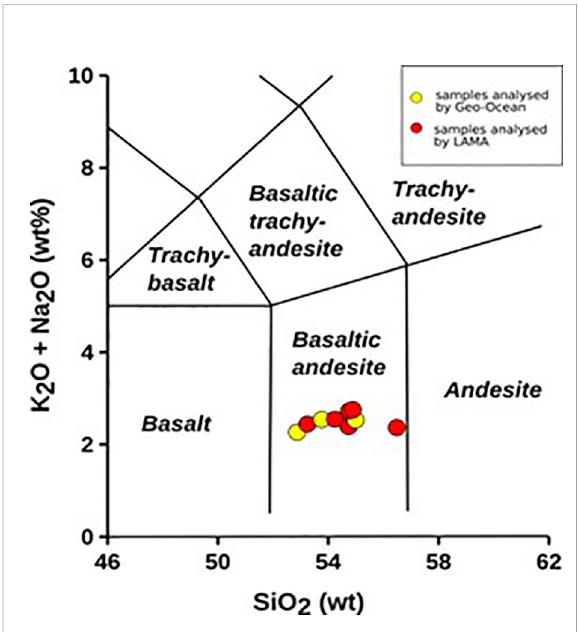
FIGURE 6 SiO 2 versus total alkali of ash samples analyzed by Geo-Ocean (in yellow) and LAMA (in red) indicating that the ash samples are of basaltic andesite